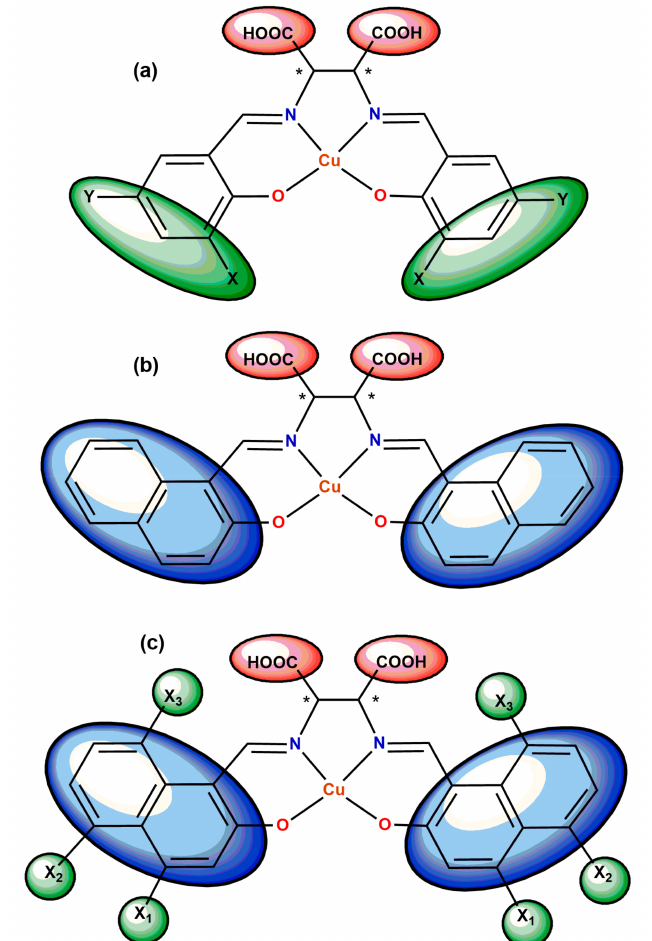
Figure 3. Design of chiral salen-type Schiff base Cu(II) complexes having ( a ) halogen substituents (X, Y) or ( b ) extended π -conjugated system and ( c ) both of these features (* denotes an asymmetric carbon atom) [33,40,41].